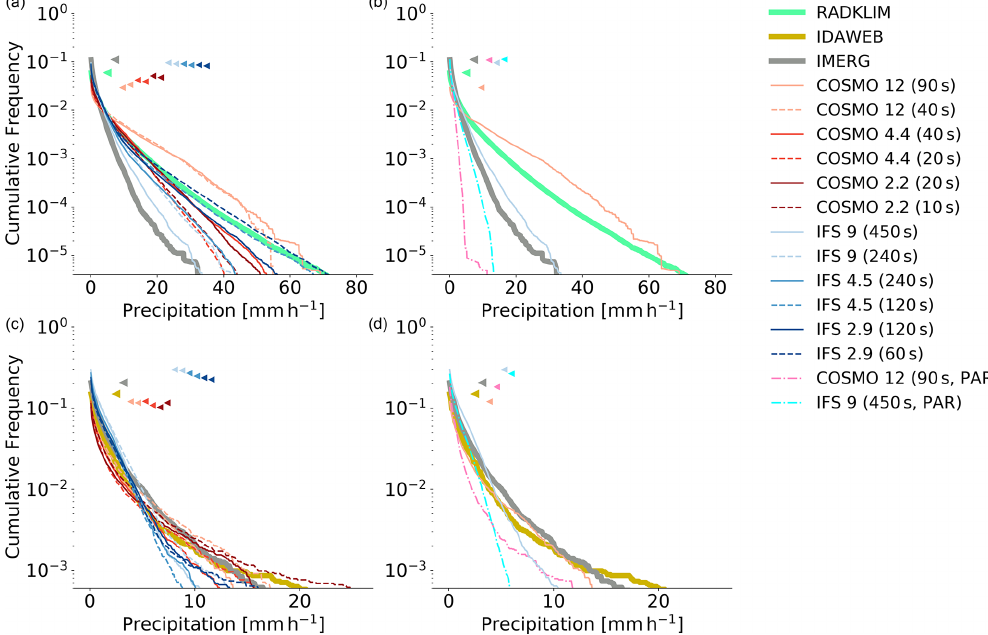
Figure 4. Same as Fig. 3 but for the RADKLIM domain (a, b) and IDAWEB station data (c, d) . Note the different scales for the two